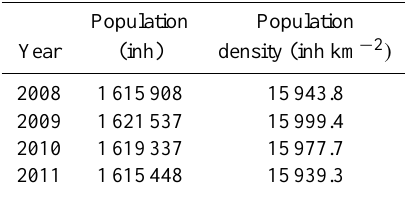
Table 1. Population and population density in the municipality of Barcelona during the period 2008–2011. Source: Idescat